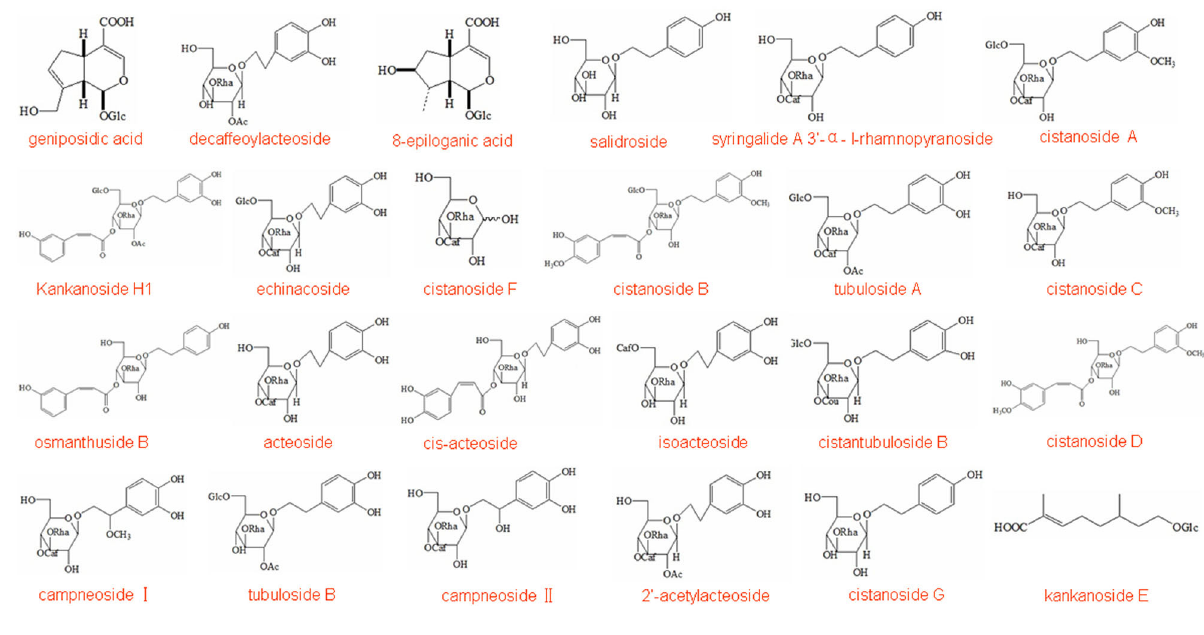
Figure 2: The structure of compounds.